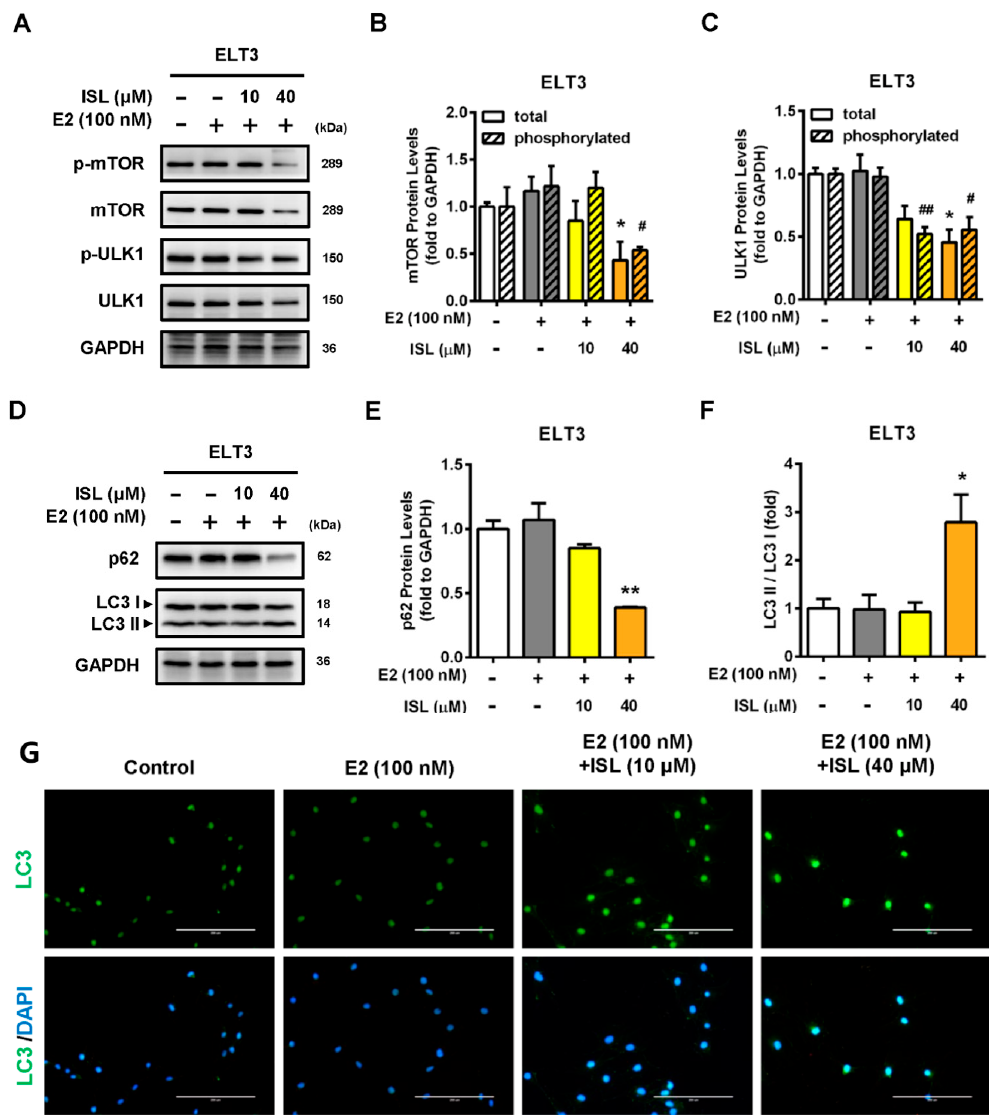
Figure 6. ISL triggered autophagy in ELT3 cells. ELT3 cells were treated with E2 alone or a combination of E2 and ISL (10 or 40 µ M) for 48 h. ( A , D ) Cells were lysed, and then autophagy-associated proteins were analyzed by Western blot. ( B – F ) Each target protein was normalized to GAPDH expression in ELT3 cells. ( G ) The expression of LC3II (green) and DAPI (blue) immunofluorescence of ELT3 cells was evaluated (magnification 200 × ; Scale bar = 200 µ m). Data represented as means ± SEM ( n = 3). * p < 0.05, ** p < 0.01 compared with the total protein level of E2-treated group. # p < 0.05, ## p < 0.01 compared with the phosphorylated protein level of E2-treated group.